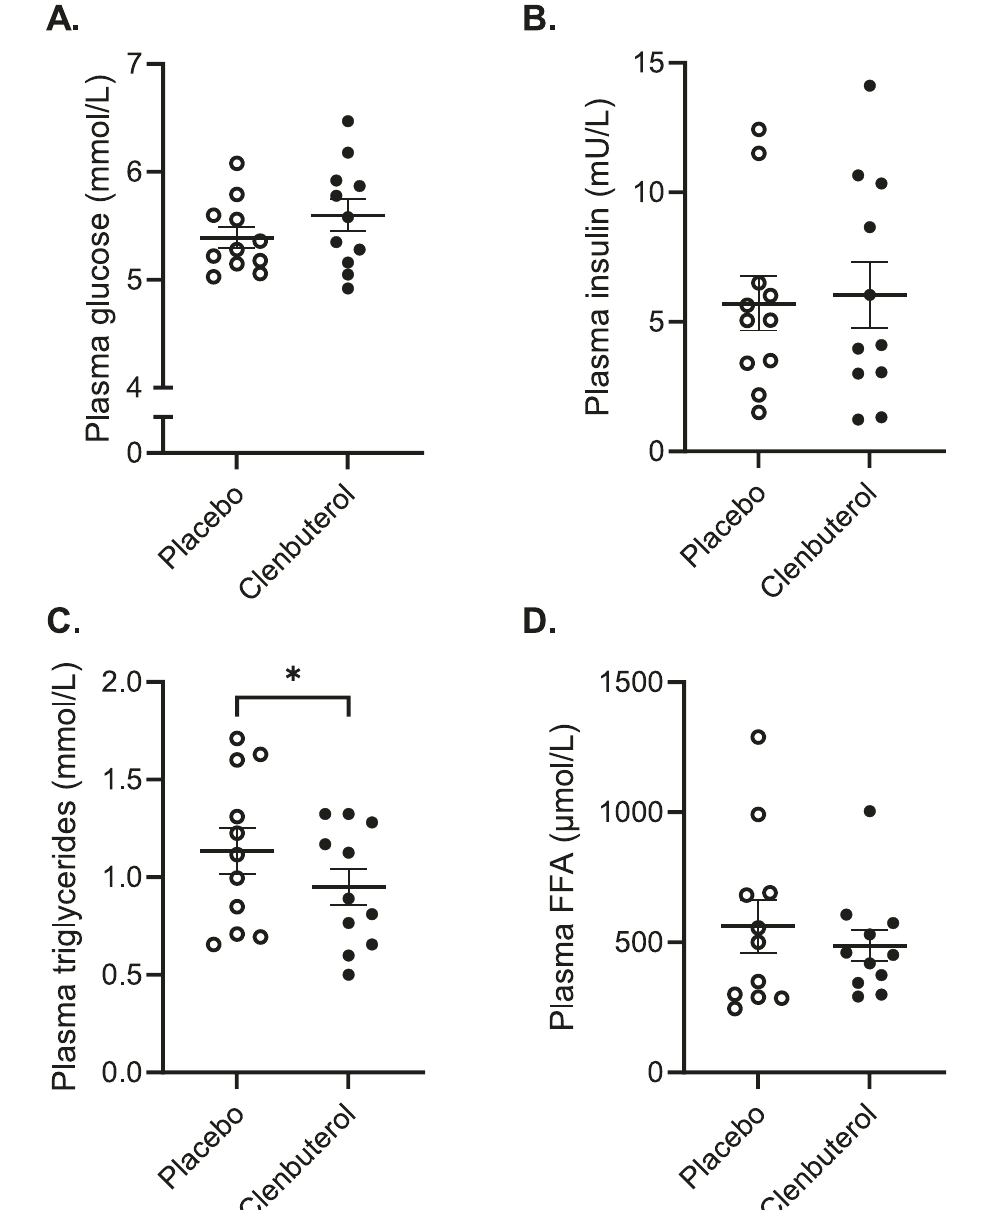
Fig. 6 | The effect of prolonged clenbuterol treatment on fasting plasma sub- strate concentrations. A Plasma glucose concentrations (mmol/L). B Plasma insulin concentrations (mU/L). C Plasma triglyceride concentrations (mmol/L) ( p =0.02). D Plasma free fatty acid concentrations ( µ mol/L). FFA free fatty acid. All